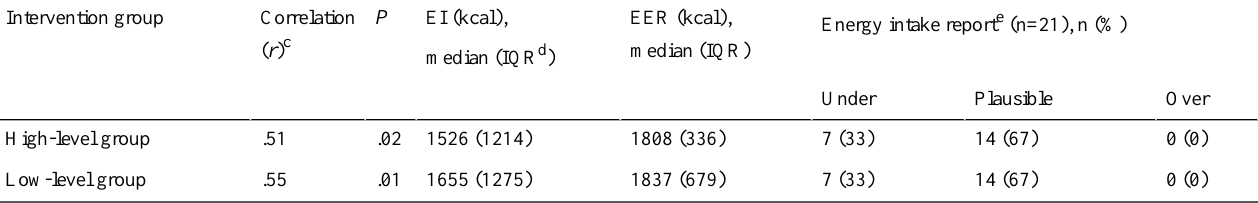
Table 4. Comparison of reported energy intake (EI) a with estimated energy requirement (EER) b according to type of